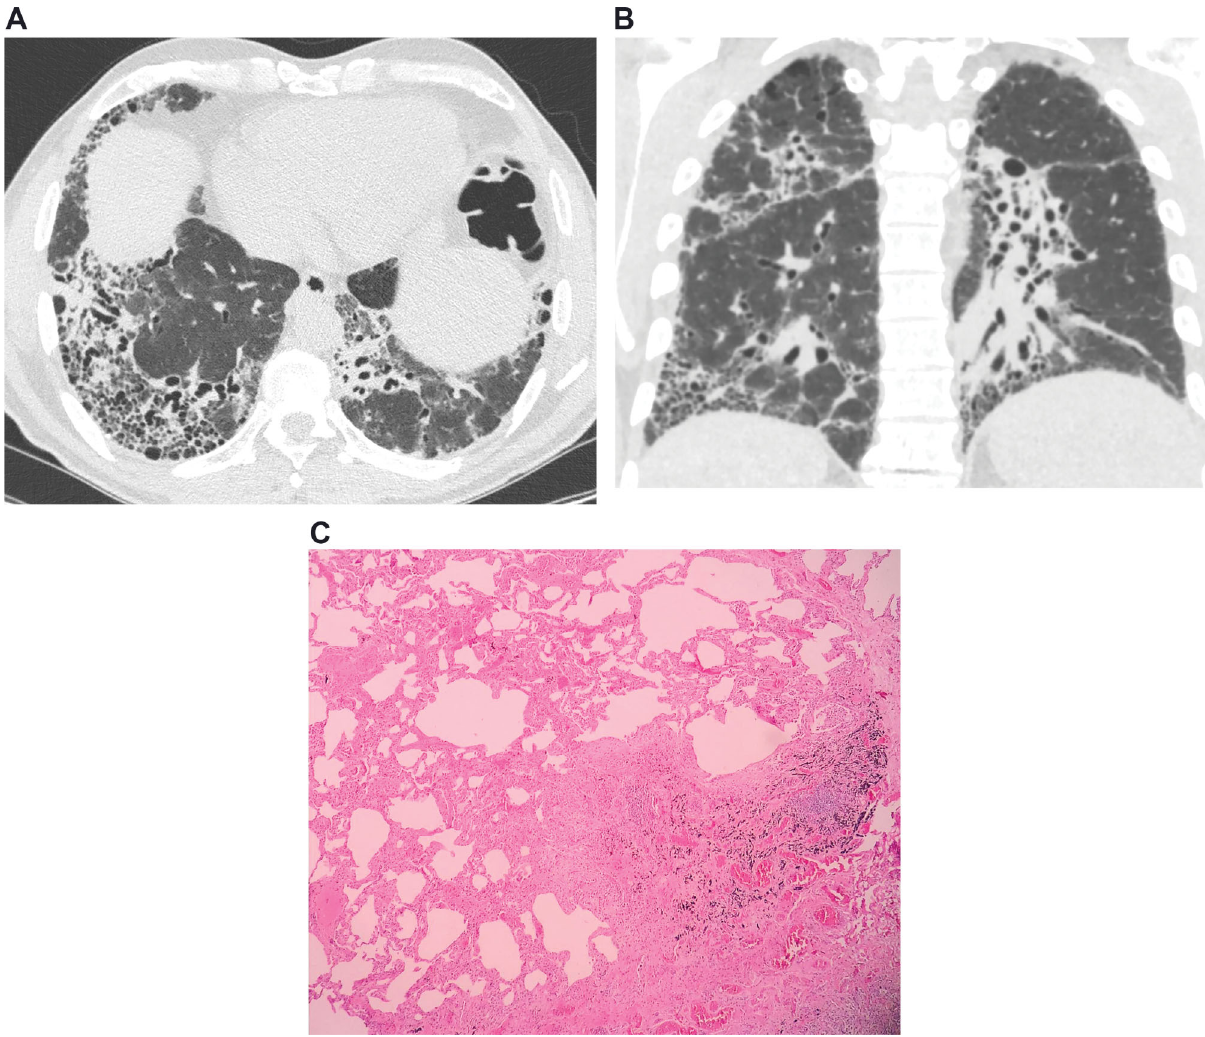
Figure 2 - Images from a 53-year-old male with idiopathic pulmonary fibrosis. (a) Axial and (b) coronal computed tomography images demonstrating areas of honeycombing, reticulation and subpleural predominance. (c) Histopathology images demonstrating areas of marked fibrosis, with architectural distortion and fibroblast foci, alternating with areas of normal